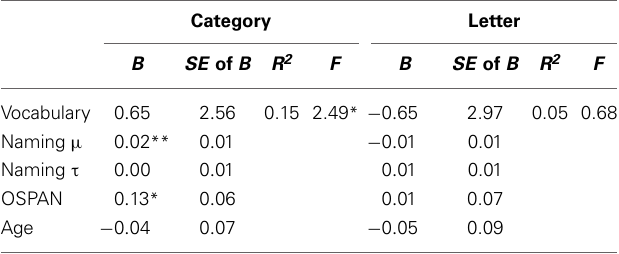
Table 6 | Results of the multiple regression analysis with subsequent response time (RT) of category and letter fluency tasks as criterion variables and vocabulary knowledge, ex-Gaussian parameter µ and τ of naming RT, operations span (OSPAN), and age as predictor